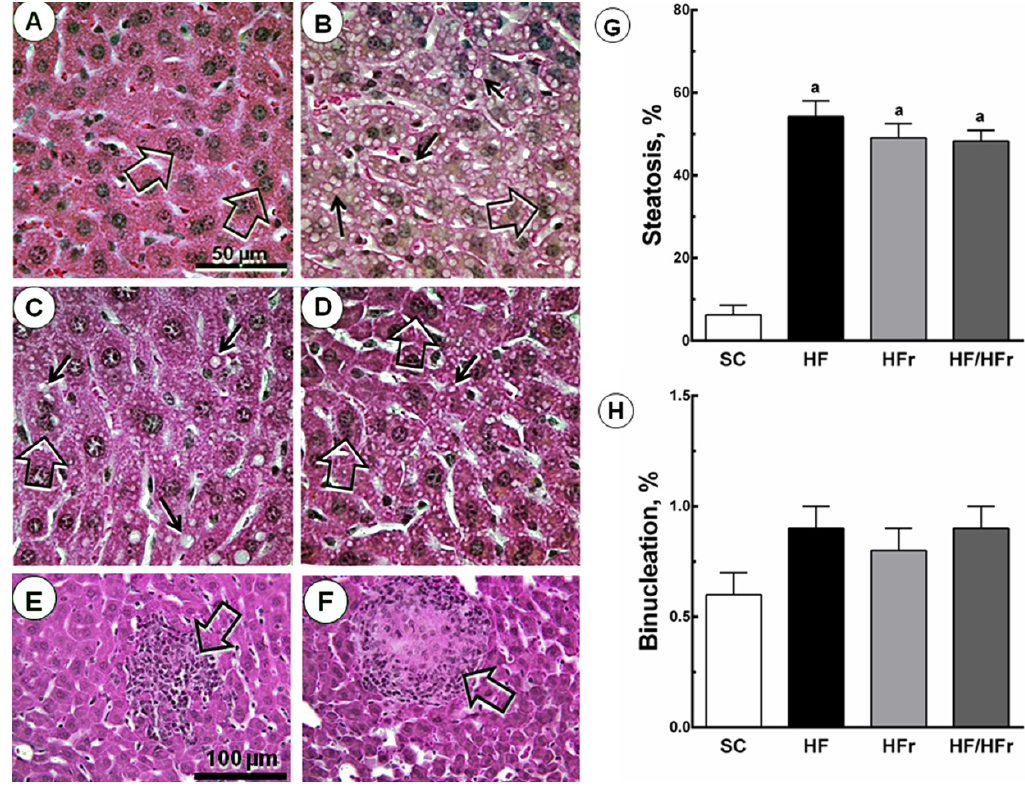
Figure 2. Volume density of hepatic steatosis and frequency of binucleation. The livers of the HF, HFr and HF/HFr groups showed increased NAFLD, steatotic macro- and microvesicles ( arrows ), and binucleation ( open arrows ). ( A ) SC; ( B ) HF; ( C ) HFr; and ( D ) HF/HFr (same magnification in A to D ). Below, scattered necroinflammatory foci ( open arrows ) ( E ) in HFr group; and ( F ) in HF/HFr group (same magnification in E and F ); The quantitative measure of ( G ) steatosis and ( H ) binucleation is shown in these graphs. Values are means ± standard error. There was a significant difference ( p ≤ 0.05) compared with the a SC